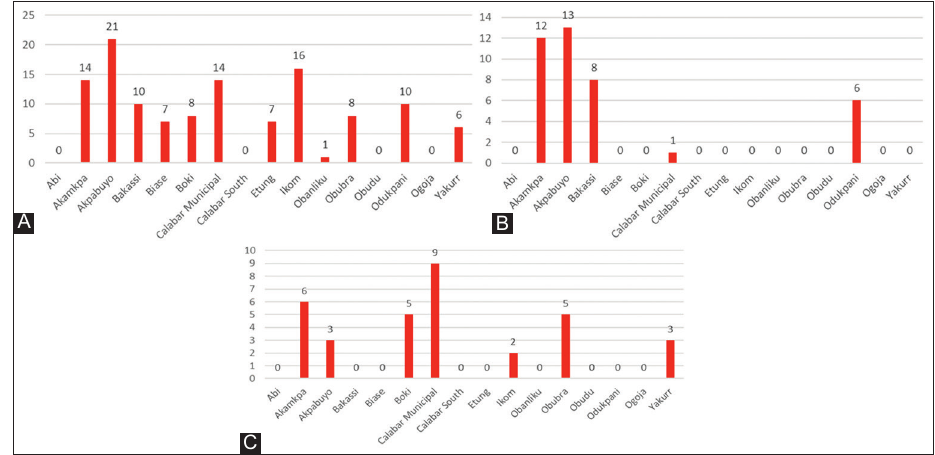
FIGURE 2. (A) Hotspots at 90% CI showing the distribution of HIV positive clients. (B) Hotspots at 95% CI showing the distribution of HIV positive clients. (C) Hotspots at 99% CI showing the distribution of HIV positive